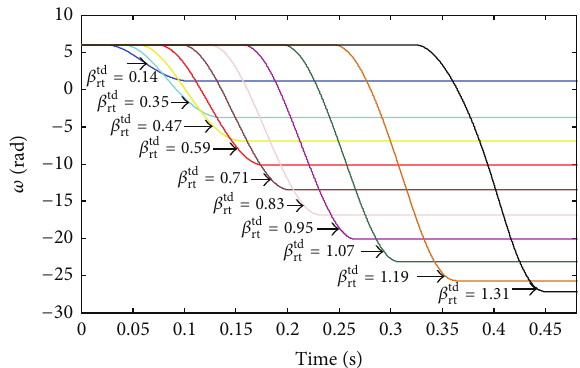
Figure 5: Pitching angular velocities at different touchdown angles.